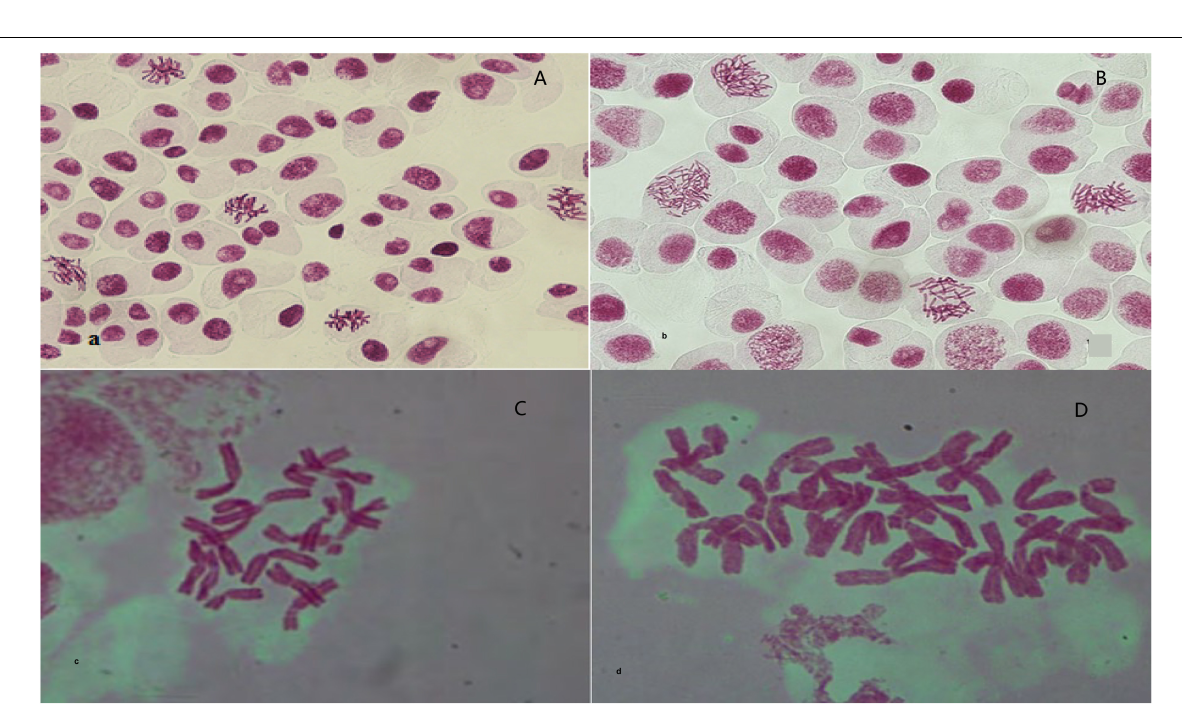
FIGURE 2 | Observation and validation of root tip chromosomes in regenerated plantlets. (A,C) Diploid garlic (2n = 2x = 16). (B,D) Tetraploid garlic (2n = 2x = 32).